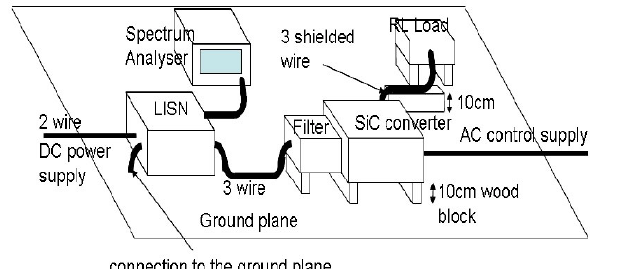
Figure 1: Experimental setup.